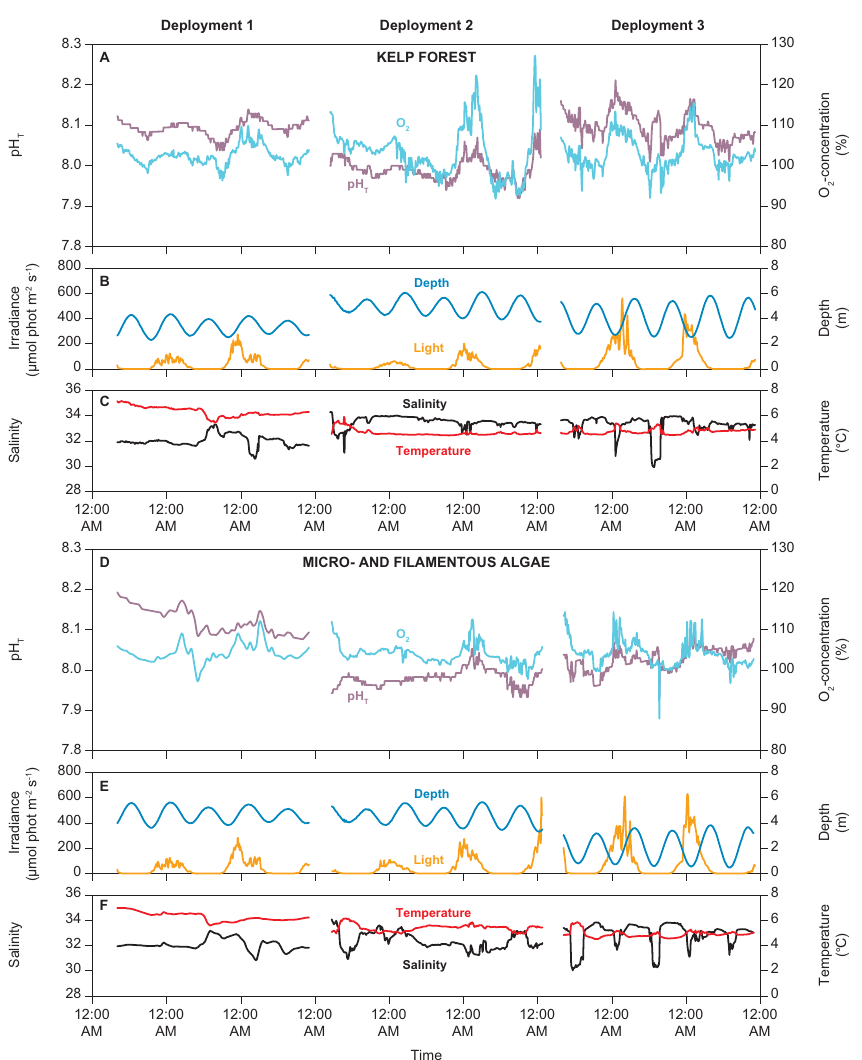
Figure 4. Diurnal variability in pH, O 2 , water depth (all measured by Hydrolab) and irradiance (measured by Odyssey loggers) at ca. 50cm above the seafloor in kelp forests (a–c) and habitats colonized by microalgae/filamentous algae (e–f) during three parallel deployment in Kobbefjord, Nuuk, 27–30 August, 30 August–2 September, and 2–5 September 2013. The deployments represent the benthic sites (#1–3, respectively) shown on the map (Fig.